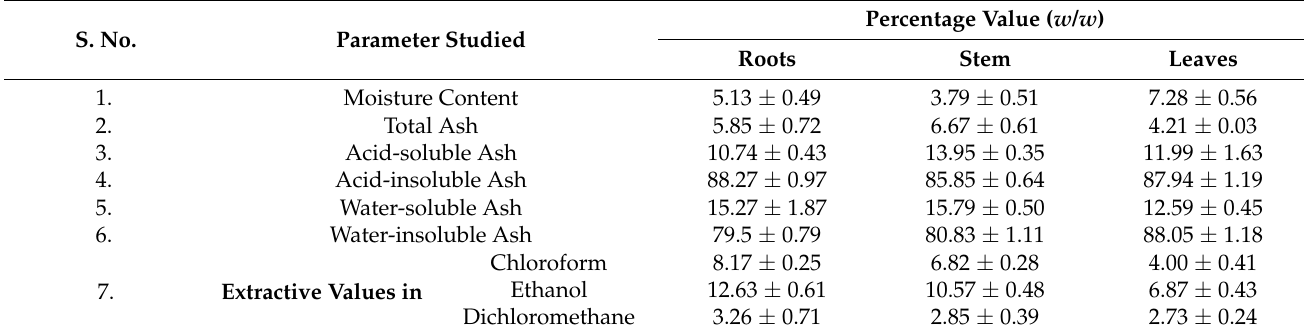
Table 1. Analytical values of N. triquetra .